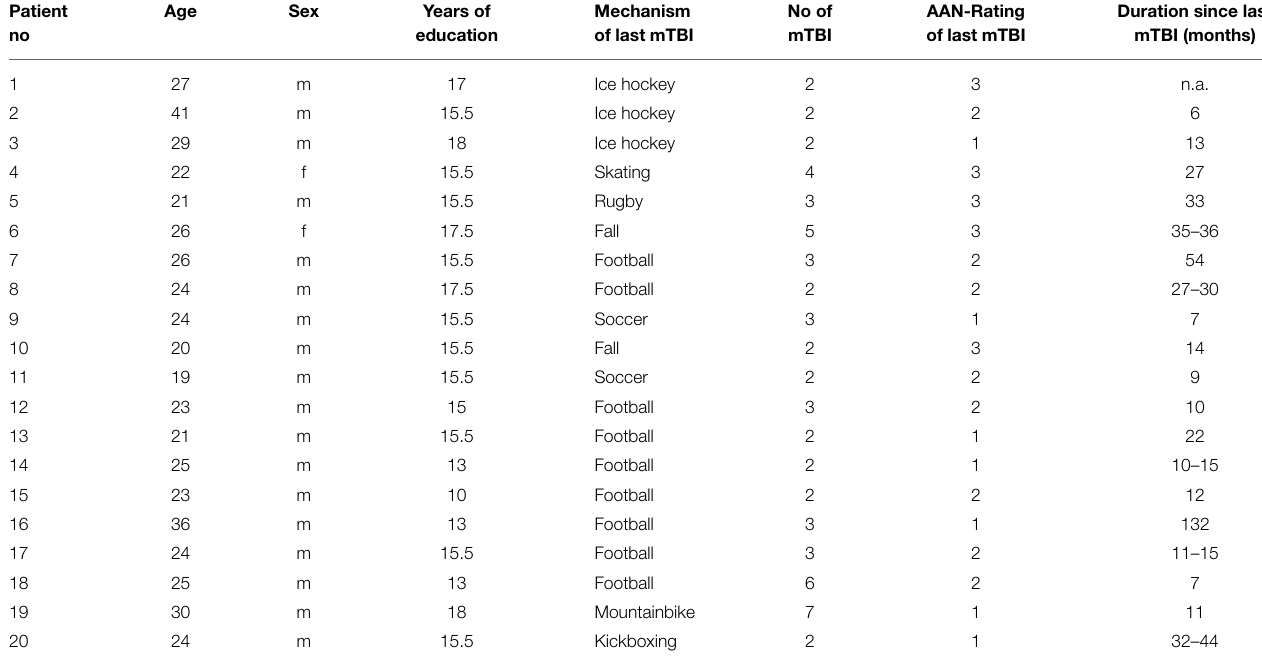
TABLE 1 | Detailed characteristics of the mTBI subjects. Patient